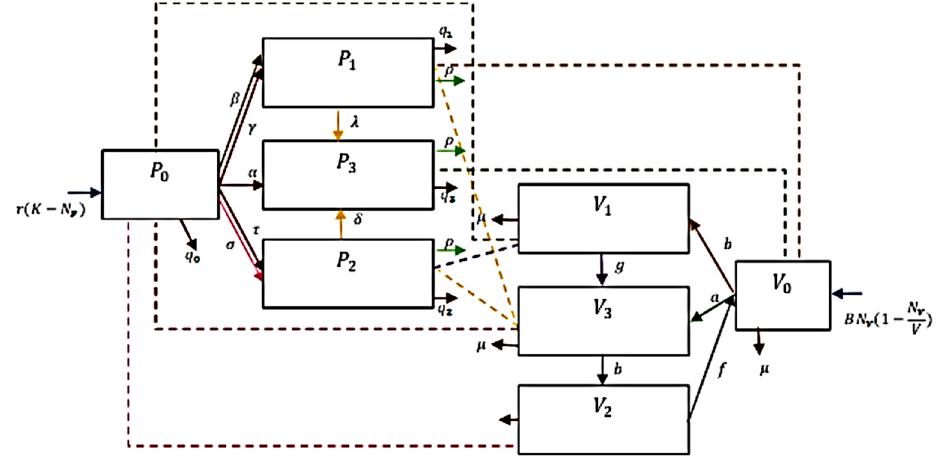
Figure 4. Schematic diagram of the model for the spread of tungro virus disease in rice plants carried out by Blas in 2017 [22].